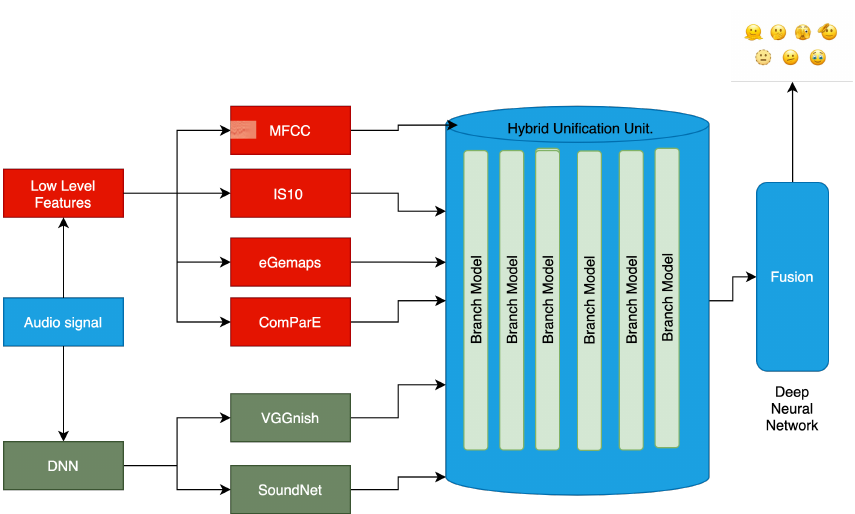
Figure 1. The suggested architecture for SER